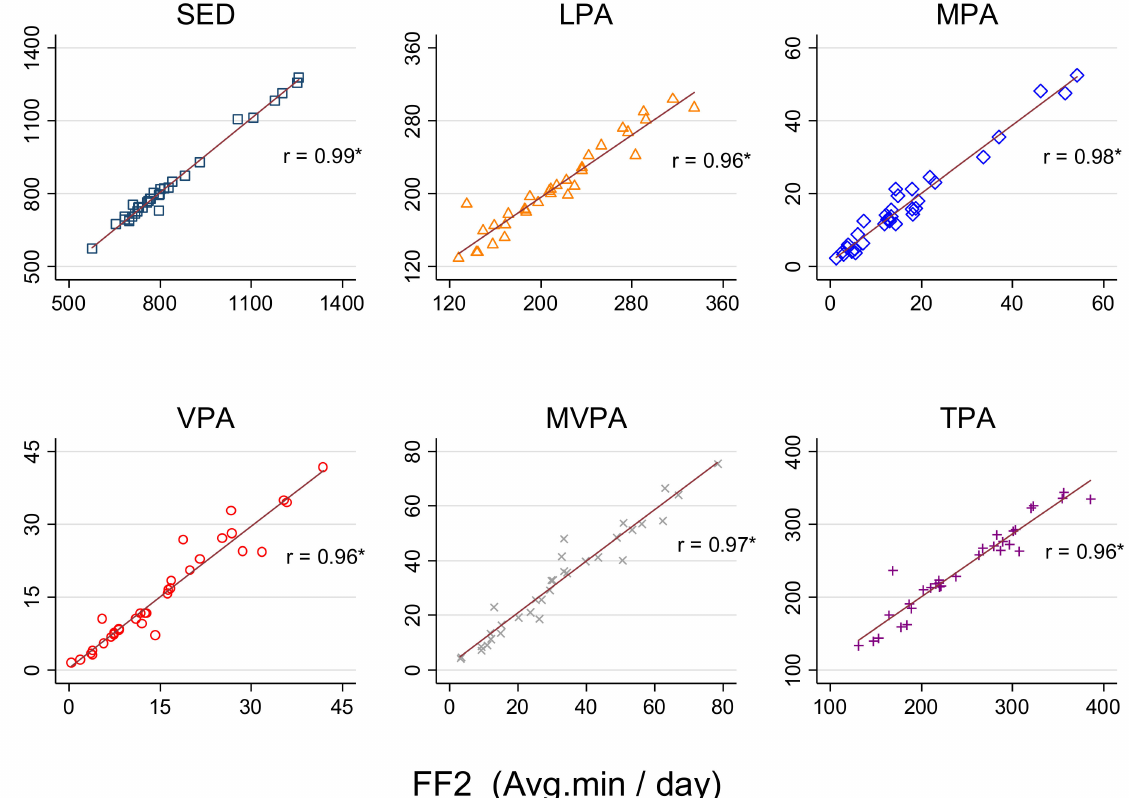
Figure 1. Relationship between FF and FF2 in estimating time spent in SED and PA. SED: Sedentary behavior; LPA: Light physical activity; MPA: Moderate physical activity; VPA: Vigorous physical activity, MVPA: Moderate-to-vigorous physical activity; TPA: Total physical activity; *: p <